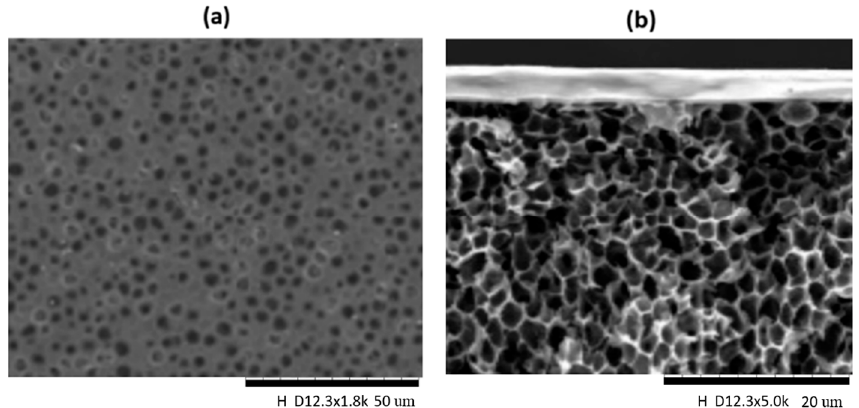
Figure 3. Surface SEM of DPC-NH 2 composite membrane for ( a ) PSF-DPC-NH 2 -0, ( b ) PSF-DPC-